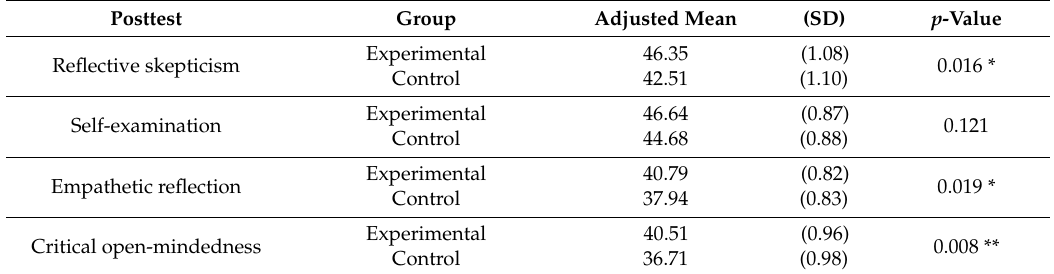
Table 4. MANCOVA and the adjusted posttest means for the RTS-HSP.